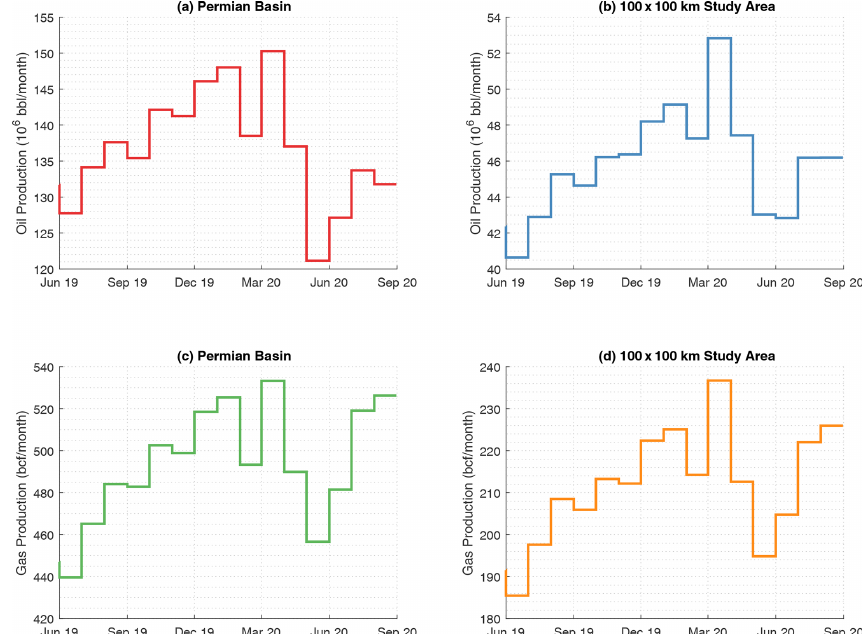
Figure E1. Monthly time series of oil (a, b) and natural gas (c, d) production in both the Permian Basin (a, c) and the 100km × 100km study area (b, d) (Enverus, 2021). 1 billion cubic feet (Bcf) = 2 . 8 × 10 7 m 3 ; 1 barrel of oil (bbl) = 159L.